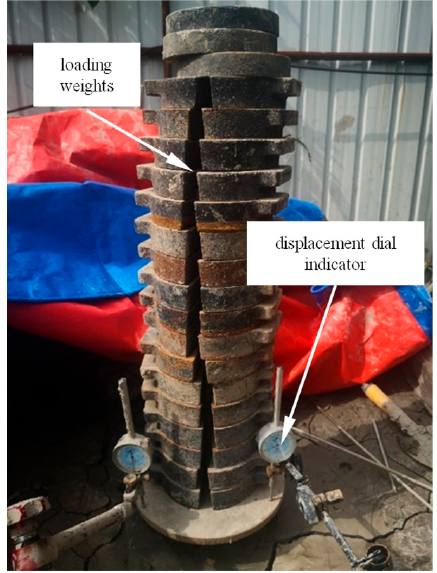
Figure 4. Direct shear test.